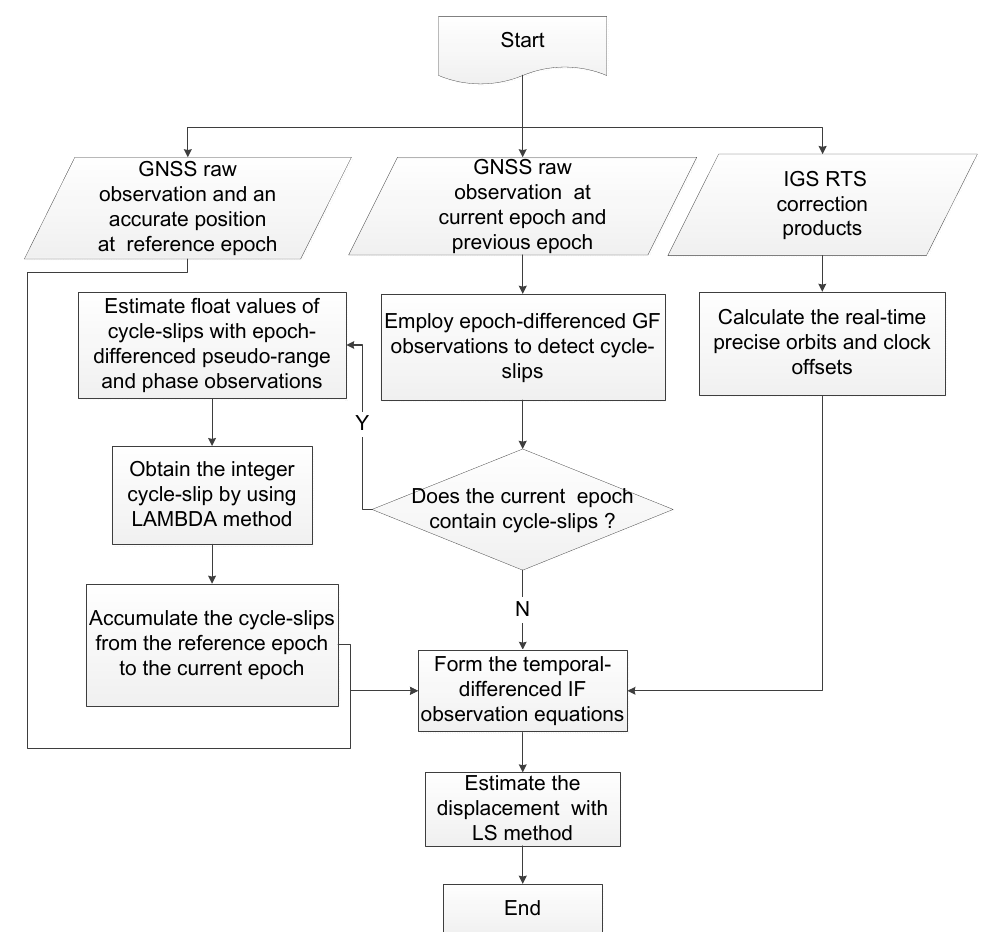
Figure 3. Flowchart of the real-time displacement retrieval with TPP method based on IGS RTS correction products.